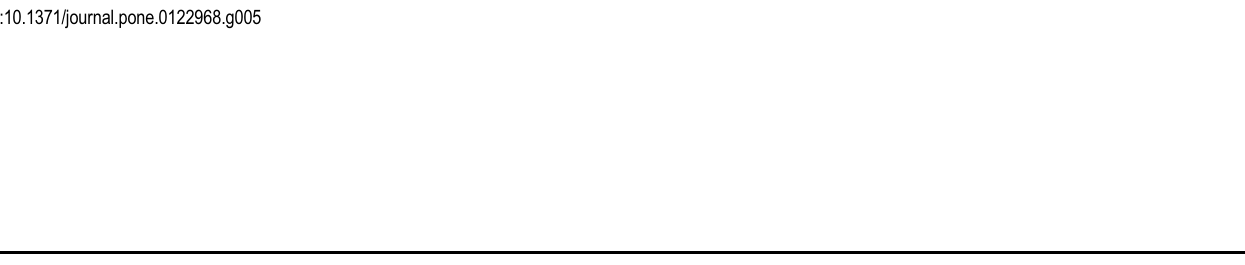
PLOS ONE | DOI:10.1371/journal.pone.0122968 April 7,